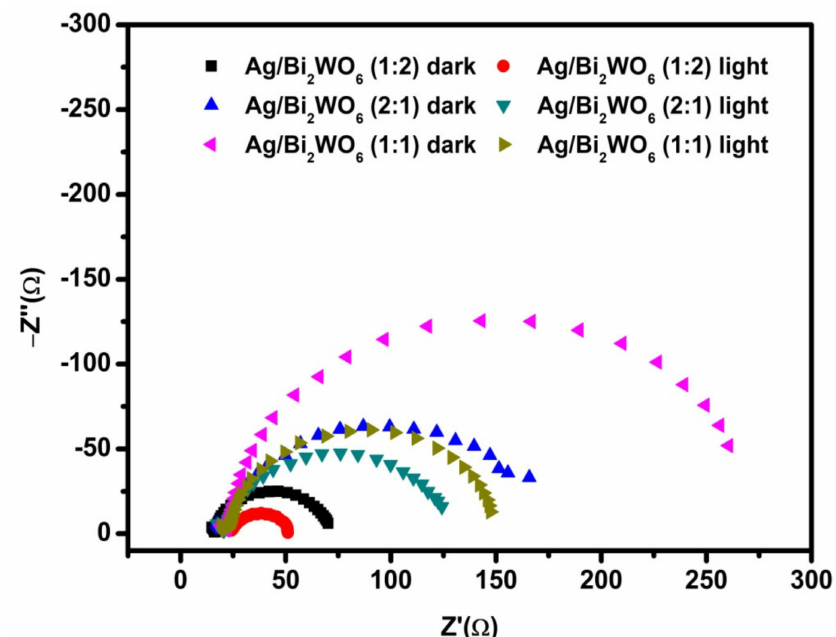
Figure 11. Nyquist plot of Ag/Bi 2 WO 6 (1:1), Ag/Bi 2 WO 6 (1:2) and Ag/Bi 2 WO 6 (2:1) in dark and light